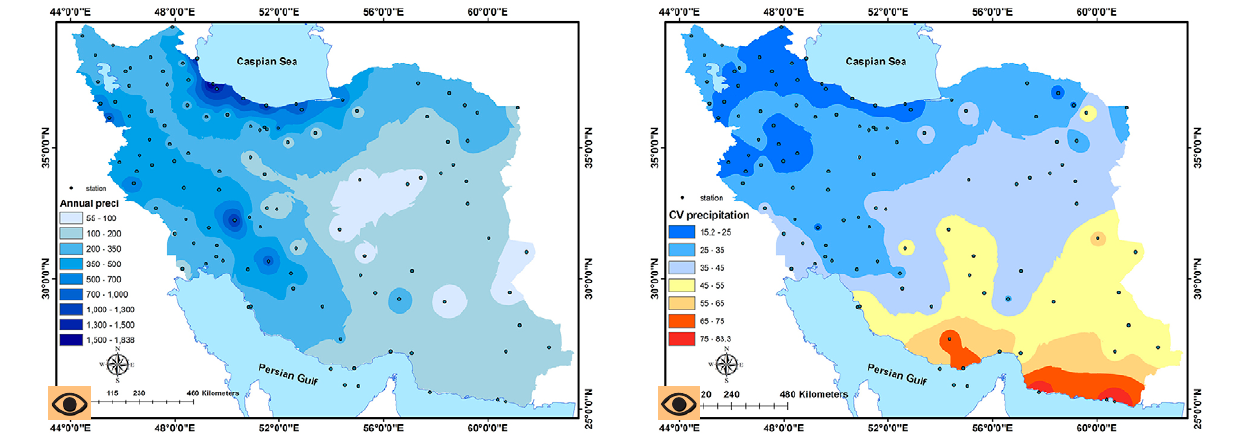
Figure 2. Spatial distribution of mean annual precipitation (mm) across Iran over the period 1988-2017